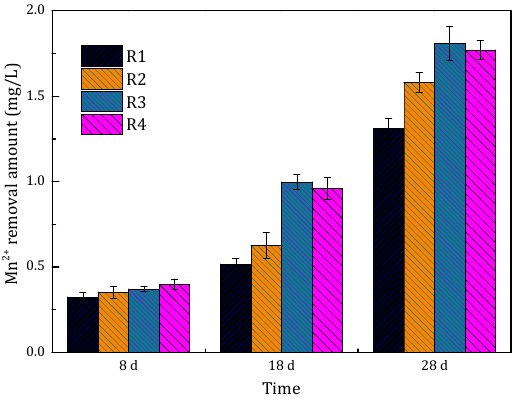
Figure 4. The comparison of the Mn 2+ removal of the filters (R1, R2, R3 and R4) at different running time.